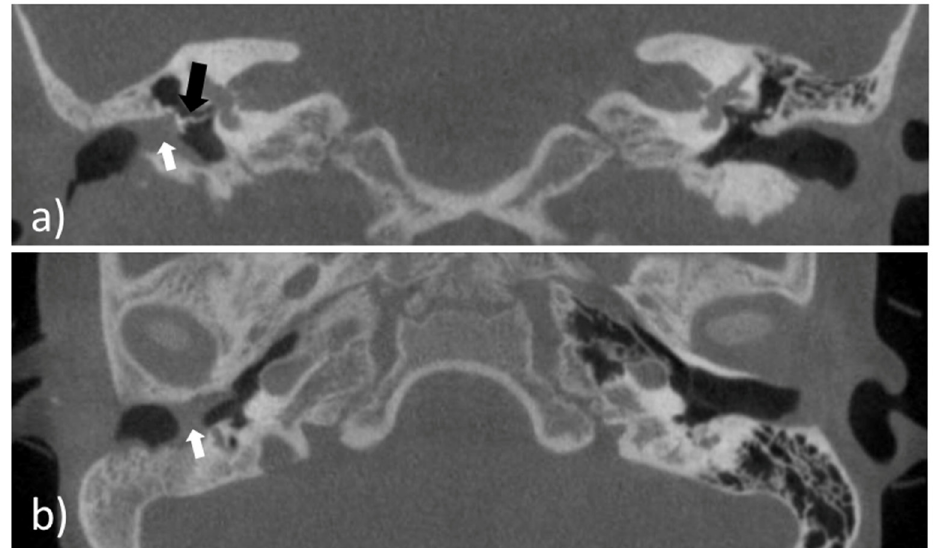
Figure 1. Cone beam computed tomography imaging of the temporal bone of the patient. ( a ) Coronal view of the external ear canal with the white arrowhead pointing to the restenosis; an aerated middle ear space and a middle ear partial ossicular replacement prosthesis (black arrowhead); ( b ) axial view of the external ear canal with the partial restenosis (white arrowhead).